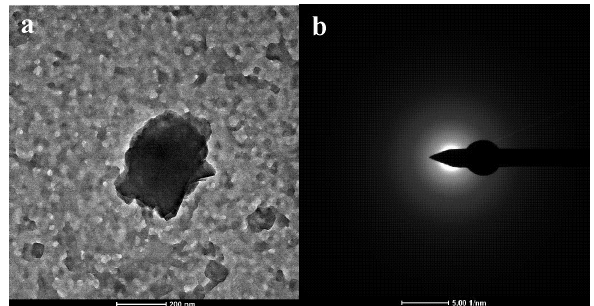
Figure 11. Panel (a) shows the TEM image and (b) SAED pattern of an O-, S-, and Co-containing particle obtained from an ascending gas flow in the soil from the Qingmingshan Cu–Ni sulfide deposit, Guangxi province.